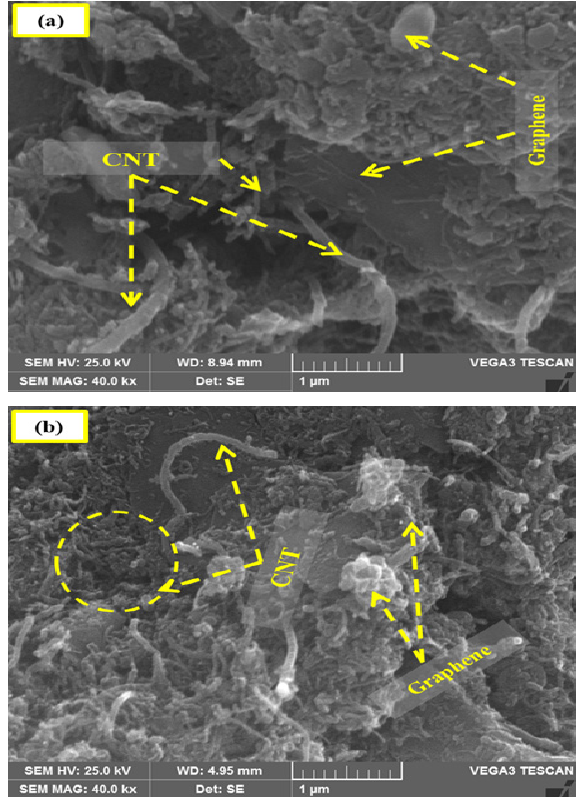
Figure 3. SEM micrographs of Al hybrid composites with (a) 1 wt% and (b) 3 wt% graphene content.